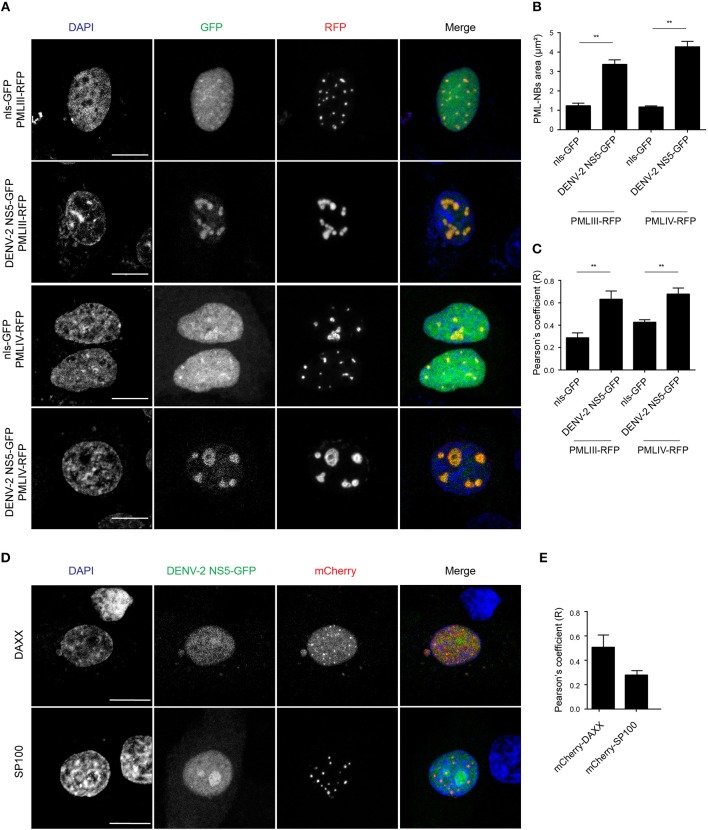
Accumulation of NS5-GFP in PML-NBs overexpressing PMLIII/-IV-RFP. (A) A549 cells were cotransfected with vectors encoding for DENV-2 NS5-GFP or nls-GFP, and PMLIII-RFP, PMLIV-RFP, or (D) mCherry-SP100 or mCherry-DAXX as indicated. At 24 h p.t., cells were fixed and confocal images were acquired using a Zeiss LSM710 setup. Scale bar: 10 μm. (B) Quantification of the mean PML-NB area in A549 cells (n > 20 for each condition and experiment) co-expressing DENV-2 NS5-GFP or nls-GFP and PMLIII- or IV-RFP was performed using FIJI. Data represent the mean ± SD from three independent experiments, each performed in triplicate. **p < 0.01 (Student's t test) (C,E). Quantification of the Pearson's coefficient was performed using FIJI. At least 20 cells per condition and per experiment were quantified. Data represent the mean ± SD from three independent experiments, each performed in triplicate. **p < 0.01 (Student's t test).